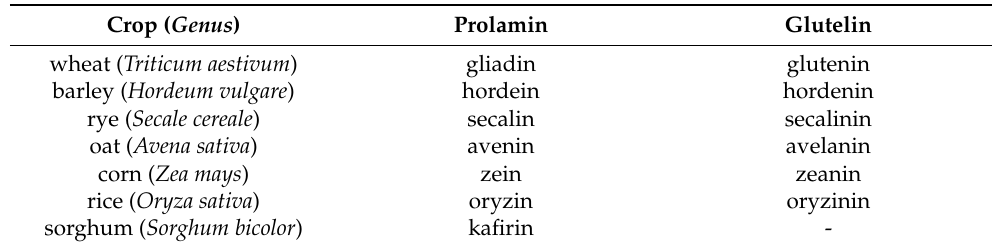
Table 1. Gluten consists of a mixture of proteins combining prolamins and glutelins. Their respective names are given to different crops [1,4,5]. While wheat, barley, and rye are known as gluten-containing crops that are toxic for patients with celiac disease, corn, rice, and sorghum are well-tolerated. Oat stands in-between, as it can induce severe problems or have no effect at all, depending on the individual